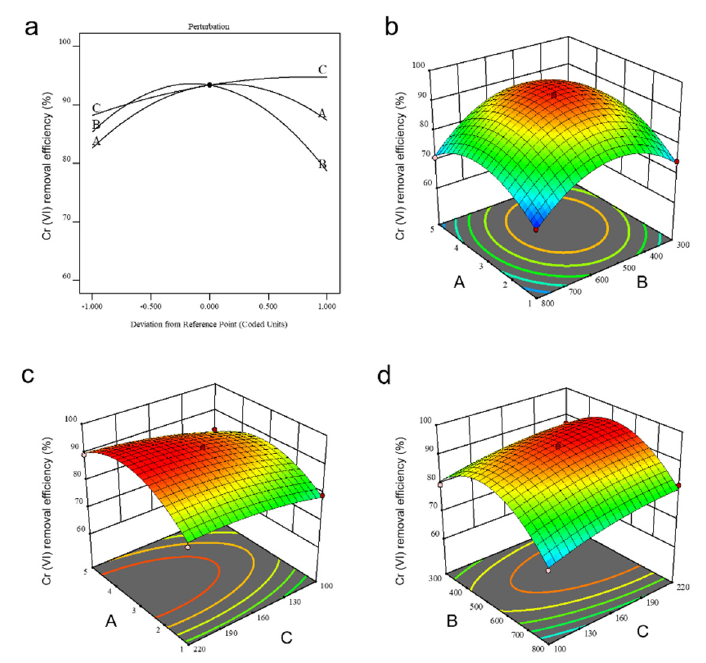
Figure 5. Surface for the effect of different variables on Cr(VI) removal. ( a ) The independent impact of three variables A, B, and C on Cr(VI) removal. A, B, and C indicate the mass ratio of SP/nZVI, the pyrolysis temperature, and the powder mesh of SP, respectively. ( b – d ) The impact of combinations of every two of the three variables on Cr(VI) removal: A and B ( b ), A and C ( c ), B and C ( d ).